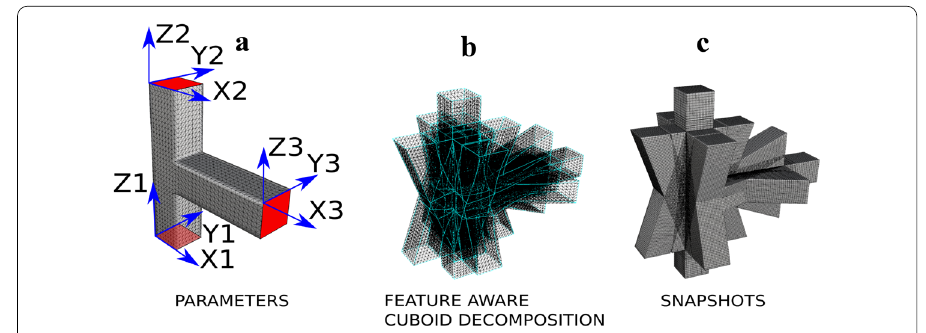
Fig. 14 Geometric snapshots generation of the T-shape. a Zero reference of geometric parameters in the global frame. b Feature-aware cuboid decomposition of all geometric instances. c Optimized set of isotopological analogous quadrilateral meshes: snapshots